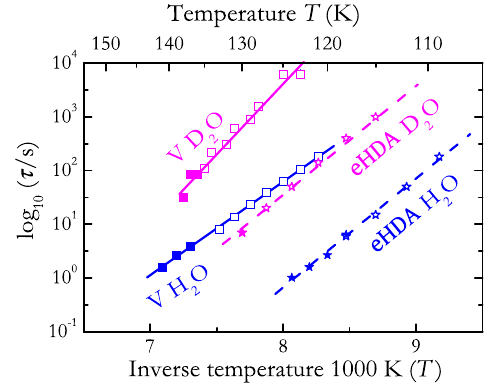
FIG. 10. Isotope effect on the dielectric timescales for ice V [24] and eHDA [47]. Similar to dielectric results for ice XII [45], the τ ð D Þ = τ ð H Þ ratio displays a significant temperature depend- ence also for ice V. Conversely, for eHDA the τ ð D Þ = τ ð H Þ ratio is